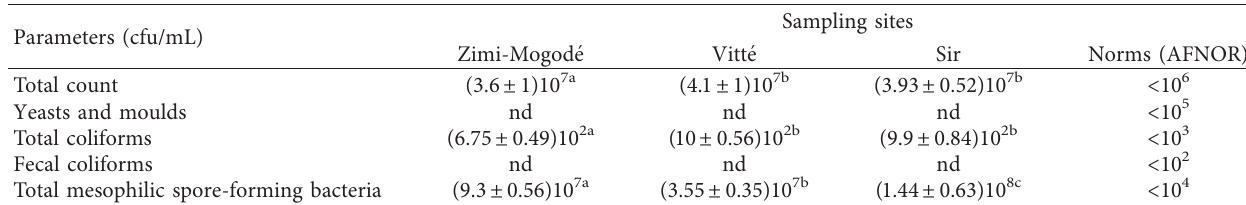
Table 5: Microbial counts of the “T´ea L´emi” wine.